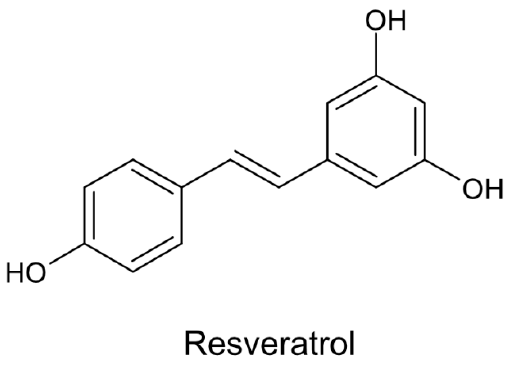
Figure 4. Chemical structure of trans-resveratrol.